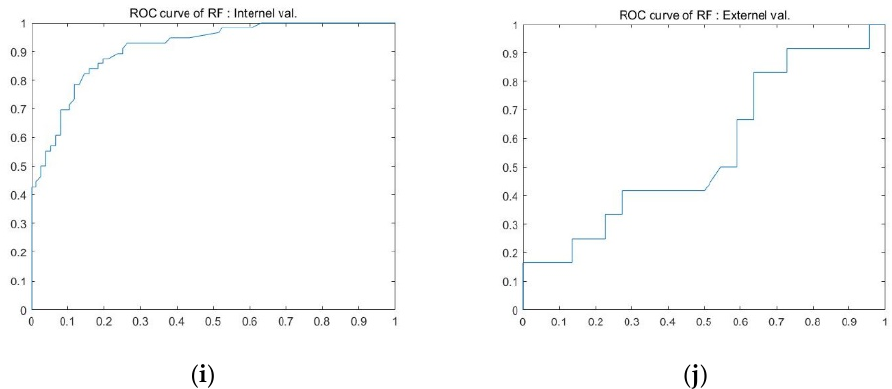
Figure 2. ROC curve of each model. ( a ) Internal validation of KNN, ( b ) external validation of KNN, ( c ) internal validation of DT, ( d ) external validation of DT, ( e ) internal validation of LR, ( f ) external validation of LR, ( g ) internal validation of SVM, ( h ) external validation of SVM, ( i ) internal validation of RF, ( j ) external validation of RF.